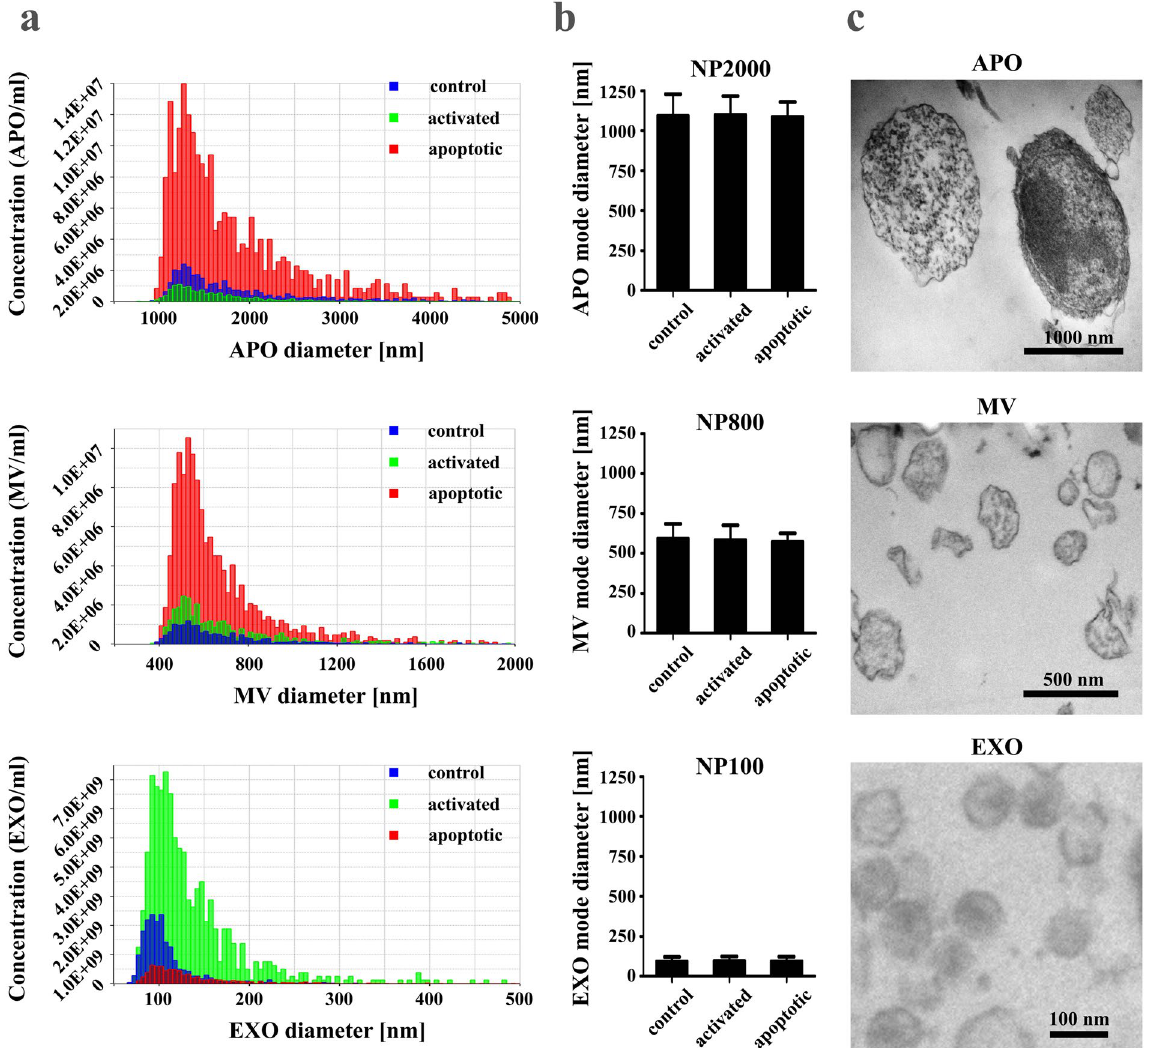
Figure 5. Characterization of extracellular vesicles (EVs) released by ciprofloxacin-exposed control, activated or apoptotic Jurkat cells. ( a ) Concentration values of EVs in 100 µ L (isolated from the supernatant of 2.5 × 10 7 cells) were determined by tunable resistive pulse sensing (TRPS), and are plotted as a function of their diameter for control, activated or apoptotic cells (blue, green or red colors, respectively). Histogram plots of EVs are representative of three independent experiments. ( b ) Mode diameters of EV subpopulations were determined by TRPS, and are presented + / − S.D. (error bars) of three independent experiments, for control, activated and apoptotic cells. NP2000, NP800 and NP100 IZON nanopore membranes were used. ( c ) Transmission electron microscopy images of apoptotic bodies (APOs), microvesicles (MVs) and exosomes (EXOs)